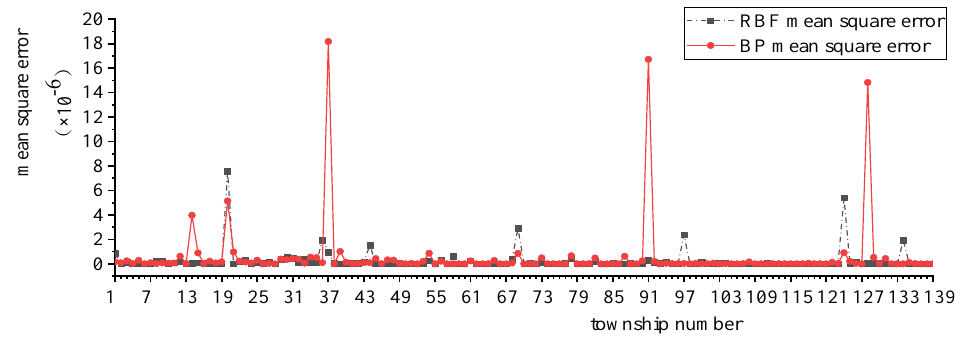
Figure 13. Comparison of mean square error of prediction results between the BP and RBF models.